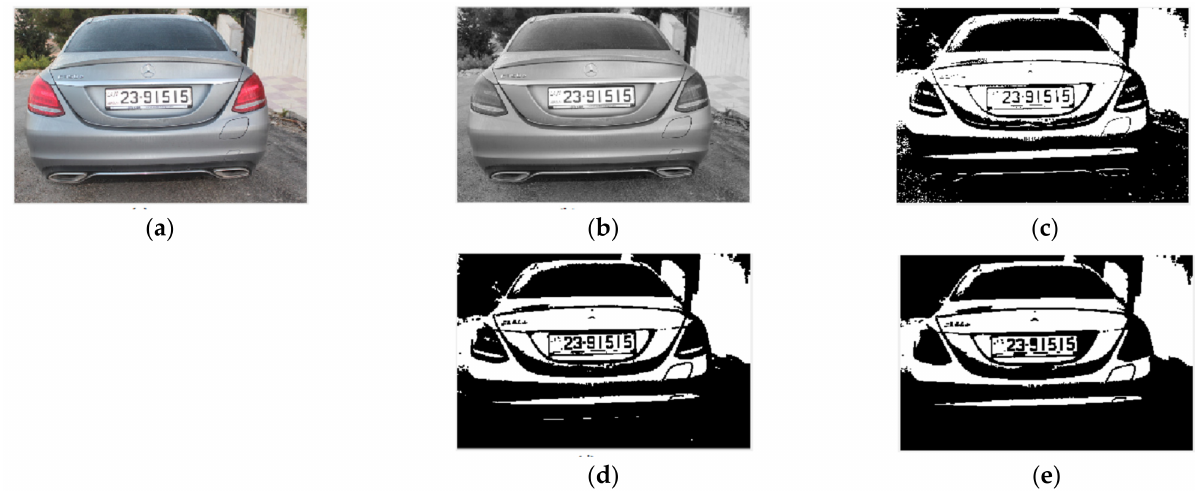
Figure 4. Pre-processing of the source image: ( a ) RGB, ( b ) gray, ( c ) binary, ( d ) binary after dilation, and ( e ) image after noise